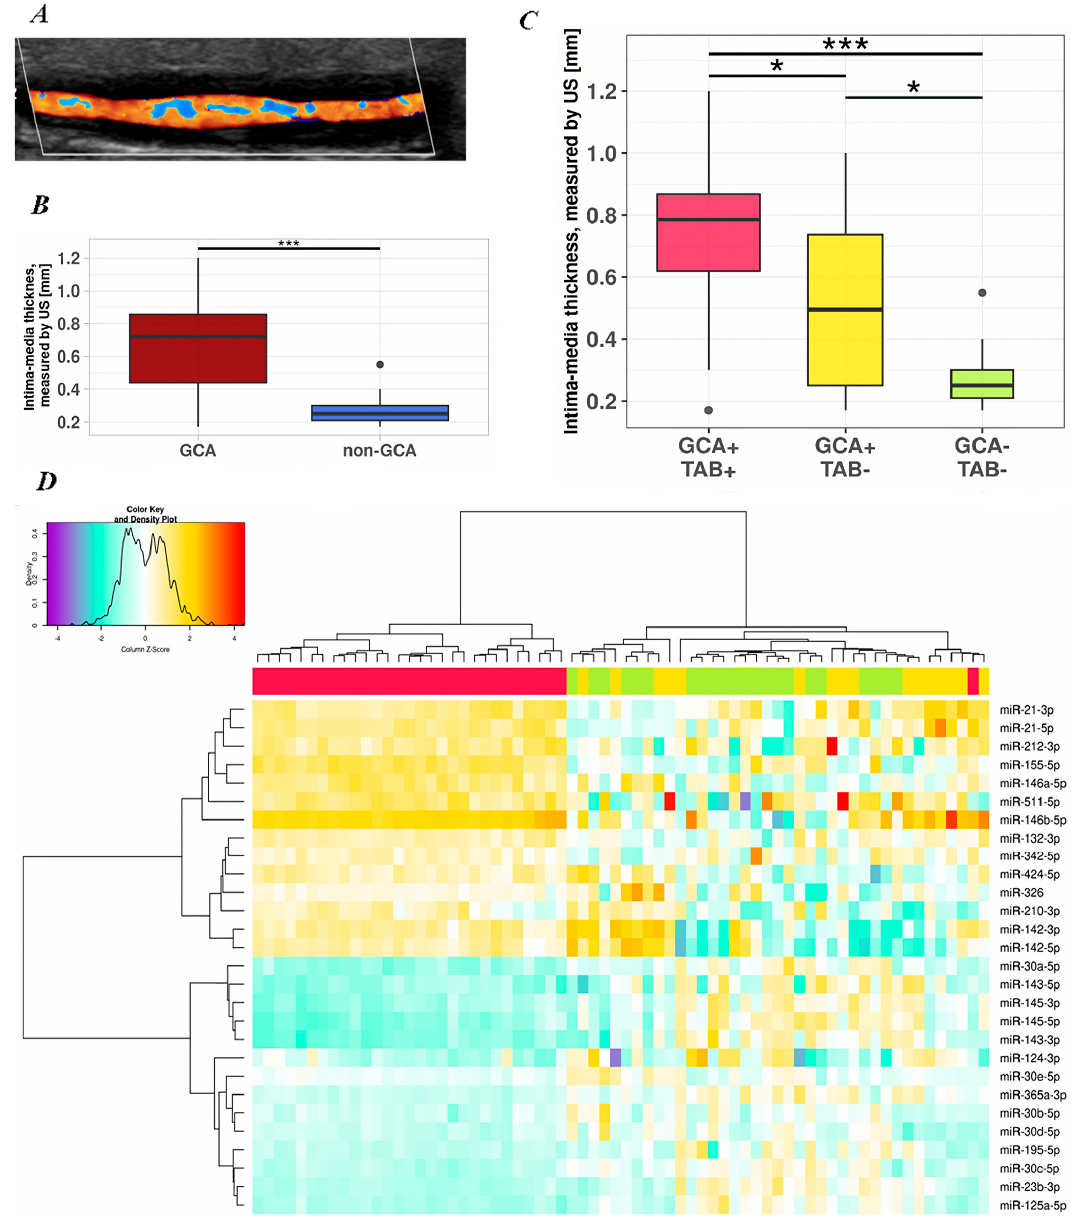
Figure 1. Longitudinal US cross section of TA in patient with GCA—a representative color Doppler US image, depicting the TA halo sign (courtesy of A. Hoˇcevar, UMC Ljubljana) ( A ). Note the darker, hypoechoic bands adjacent to colored flow inside the lumen of the artery in the longitudinal plane. Intima–media thickness measured by US of each patient group ( B , C ). Horizontal line within the boxplots denotes the median and horizontal border lines represent the interquartile range. The numbers of patients in GCA+/TAB+, GCA+/TAB − , and non-GCA (GCA − /TAB − ) patient groups were 30, 16, and 22, respectively. Statistical significance between patient groups was evaluated in a pairwise manner with Welch’s t -test (* p < 0.05; *** p < 0.001). Heatmap with unsupervised hierarchical clustering of 28 miRNAs with altered expression in TABs from GCA patients ( D ). Row Z-scores of log 2 fold-change values are presented for each miRNA in GCA+/TAB+ (red cluster; n = 30) and GCA+/TAB − (yellow cluster; n = 16) patient subgroups and non-GCA patient controls (green cluster; n = 22). Patient subgroups were established based on the intima–media TA thickness measured by